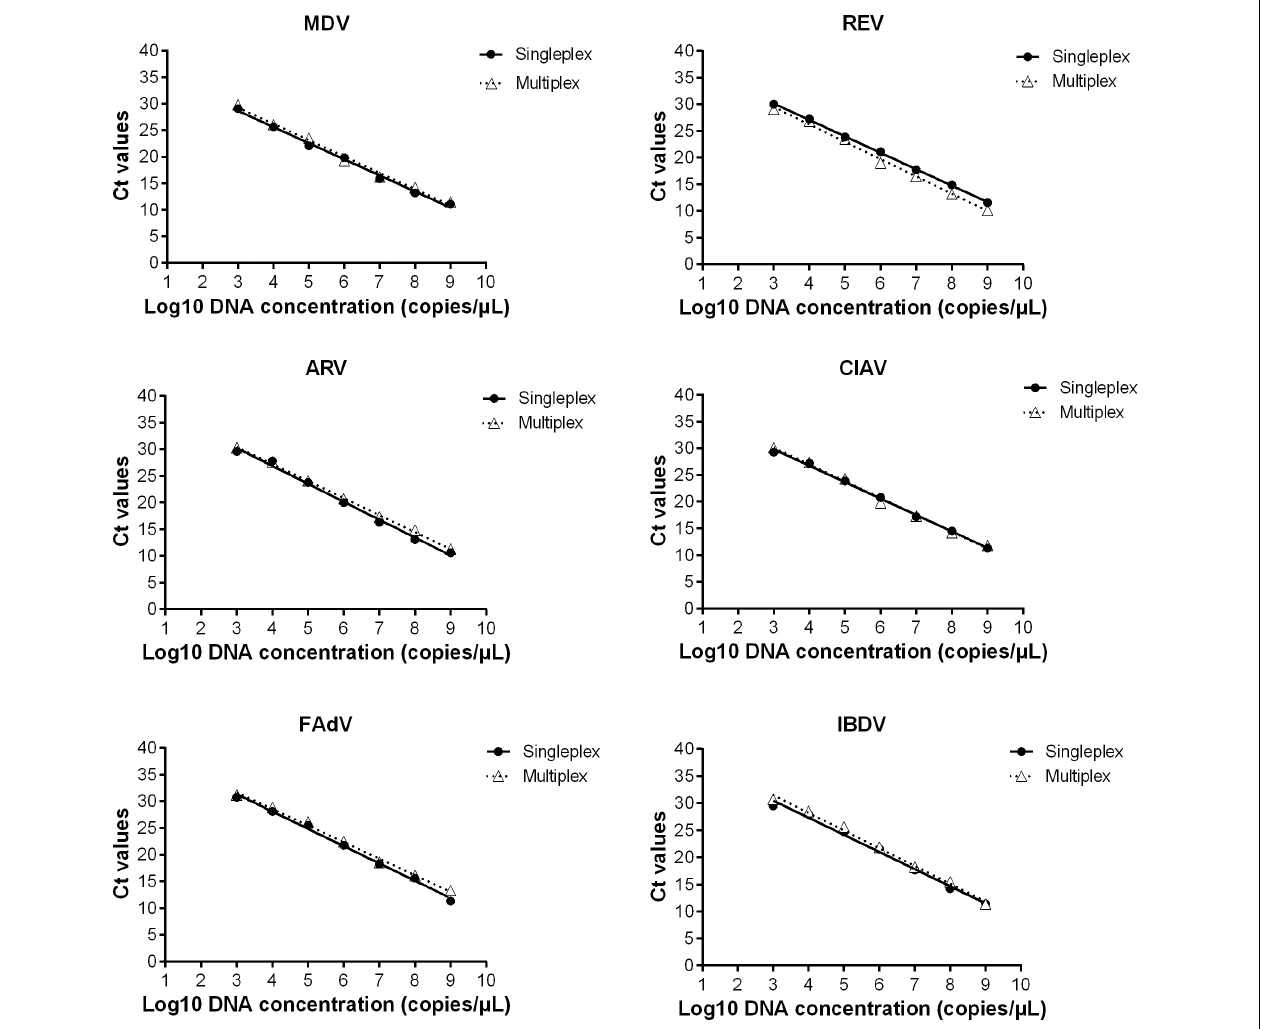
FIGURE 1 | Standard curves from the SRT-qPCR and MRT-qPCR assays for MDV, REV, ARV, CIAV, FAdV, and IBDV. The horizontal axis displays the log 10 number of plasmid copies. The vertical axis displays the mean Ct values from the SRT-qPCR and MRT-qPCR assays for each virus. TABLE 1 | The sensitivities of the SRT-qPCR and MRT-qPCR assays, based on standard curves. Virus The SRT-qPCR